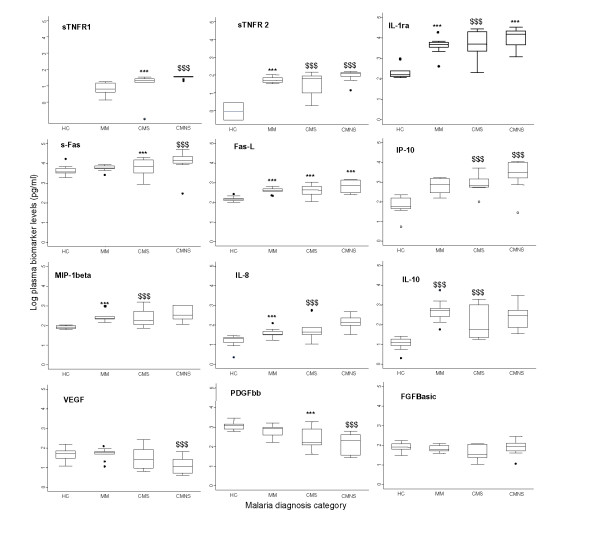
Log plasma biomarker levels and disease severity. Log median levels (pg/ml) of twelve (12) biomarkers [sTNF-R1, sTNF-R2 IL-1ra, sFas, Fas-L, IP-10, MIP-1β, IL-8, IL-10, VEGF, PDGFbb and FGF basic protein]. With the exception of sFas, Fas-L, sTNF-R1, and sTNF-R2 that were measured by ELISA, all other biomarkers were quantified via Luminex™ from blood samples collected from patients at time of admission. HC – healthy controls, MM – mild malaria, CMS – cerebral malaria survivors, CMNS – cerebral malaria non-survivors. Box plots represent medians and 25th and 75th percentiles. Bars mark the 10th and 90th percentiles, and outliers are plotted as points. HC versus MM, CMS, and CMNS: *** p < 0.05, $$$ p < 0.0045 bonferroni adjustment (alpha = 0.05/12)